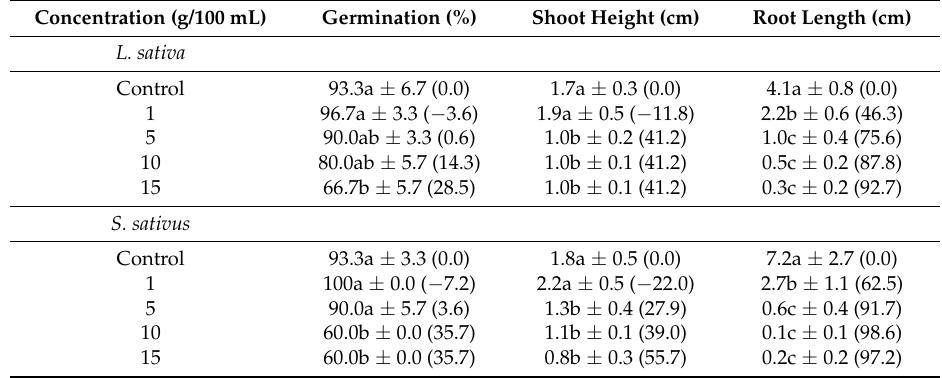
Table 2. Effects of C. crenata aqueous extracts on germination and shoot and root growth of L. sativa , R. sativus , and E.